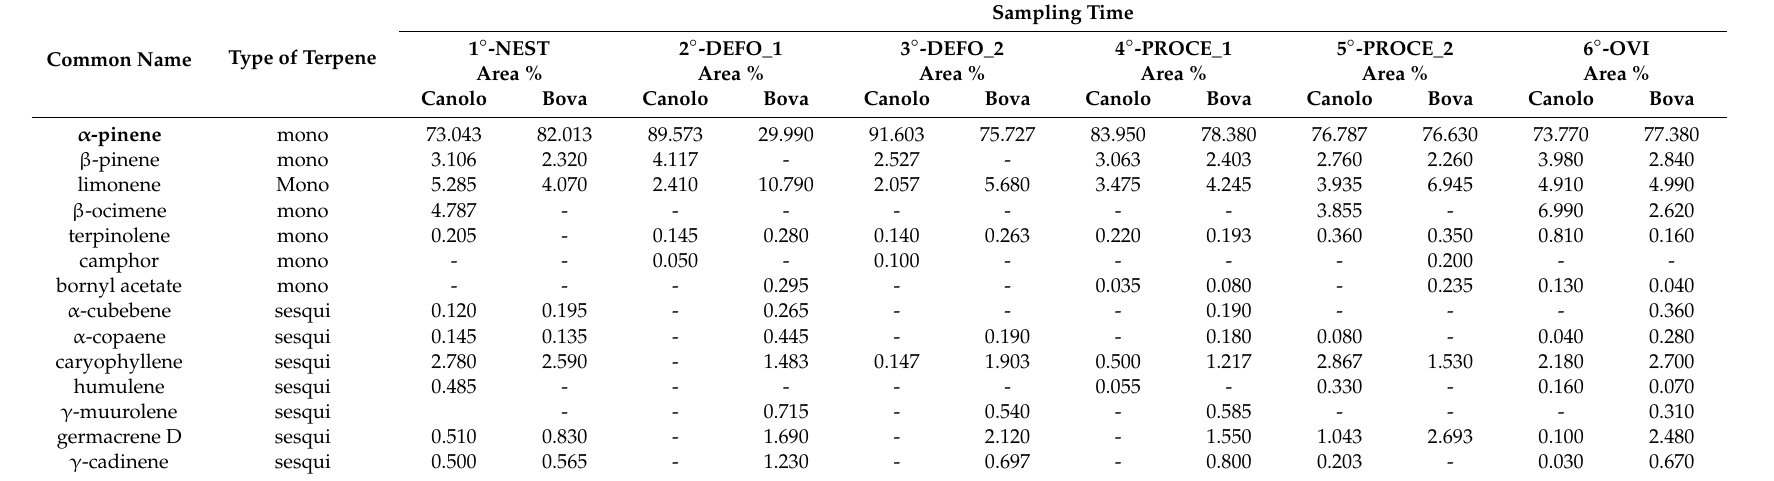
Table 2. Volatile organic compounds from the needles of not infested Calabrian pines detected in at least two replicates out of three at each sampling time in the two sampling sites of Canolo and